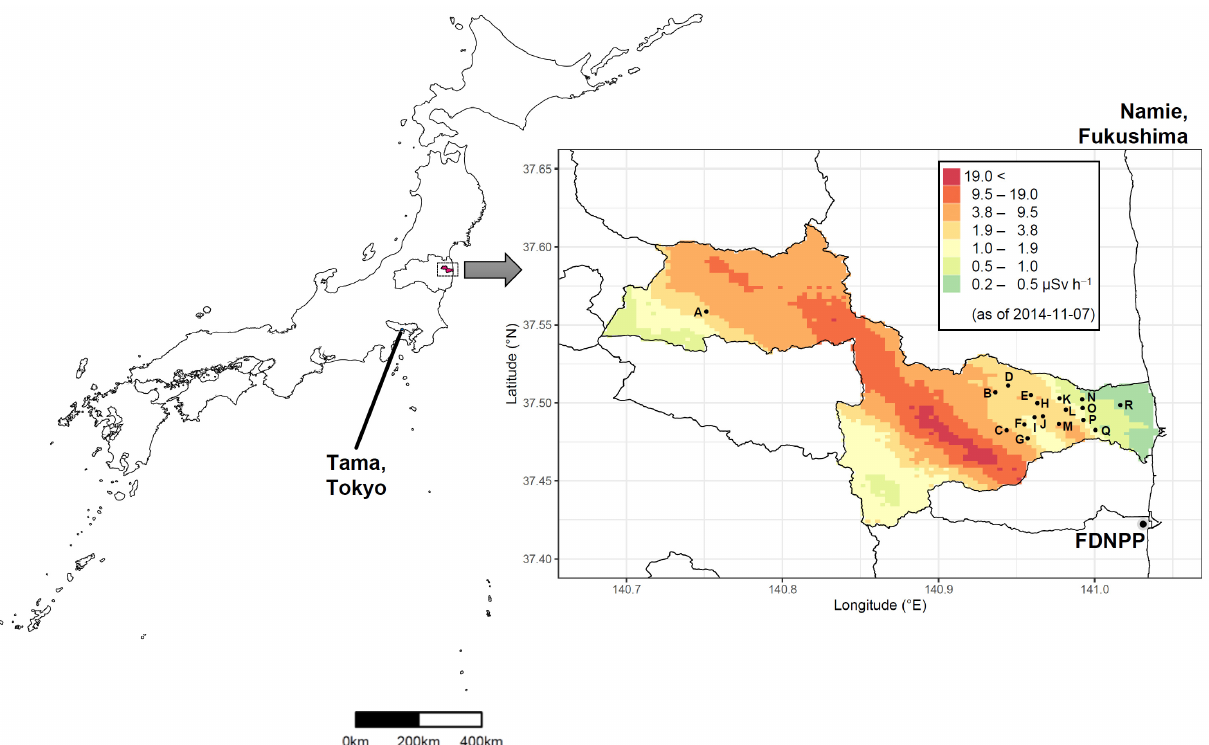
Figure 1. Sampling areas of free-roaming cats protected in Namie Town, Fukushima, and Tama area, Tokyo. The magnified map shows Namie Town and the sampling areas [(A) Tsushima, (B) Murohara, (C) Suenomori, (D) Tatsuno, (E) Karino, (F) Tajiri, (G) Obori, (H) Kakura, (I) Midorigaoka, (J) Uenohara, (K) Sakata, (L) Kawazoe, (M) Ushiwata, (N) Nishidai, (O) Gongendo, (P) Hiwatashi, (Q) Takase and (R) Kiyohashi], as well as the TEPCO Fukushima Daiichi Nuclear Power Plant (FDNPP). The maps were modified shapefiles from the National Land Numerical Information download service (data was retrieved from http://nlftp.mlit.go.jp/ksj/index.html on 5 February 2016). The heat map shows the ambient dose-rates on 7 November 2014 provided by the Nuclear Regulation Authority 9th airborne monitoring survey (data were retrieved from http://radioactivity.nsr.go.jp/ja/list/362/list-1.html on 5 February 2016). Table 1. Locations and decontamination status of sampling areas.